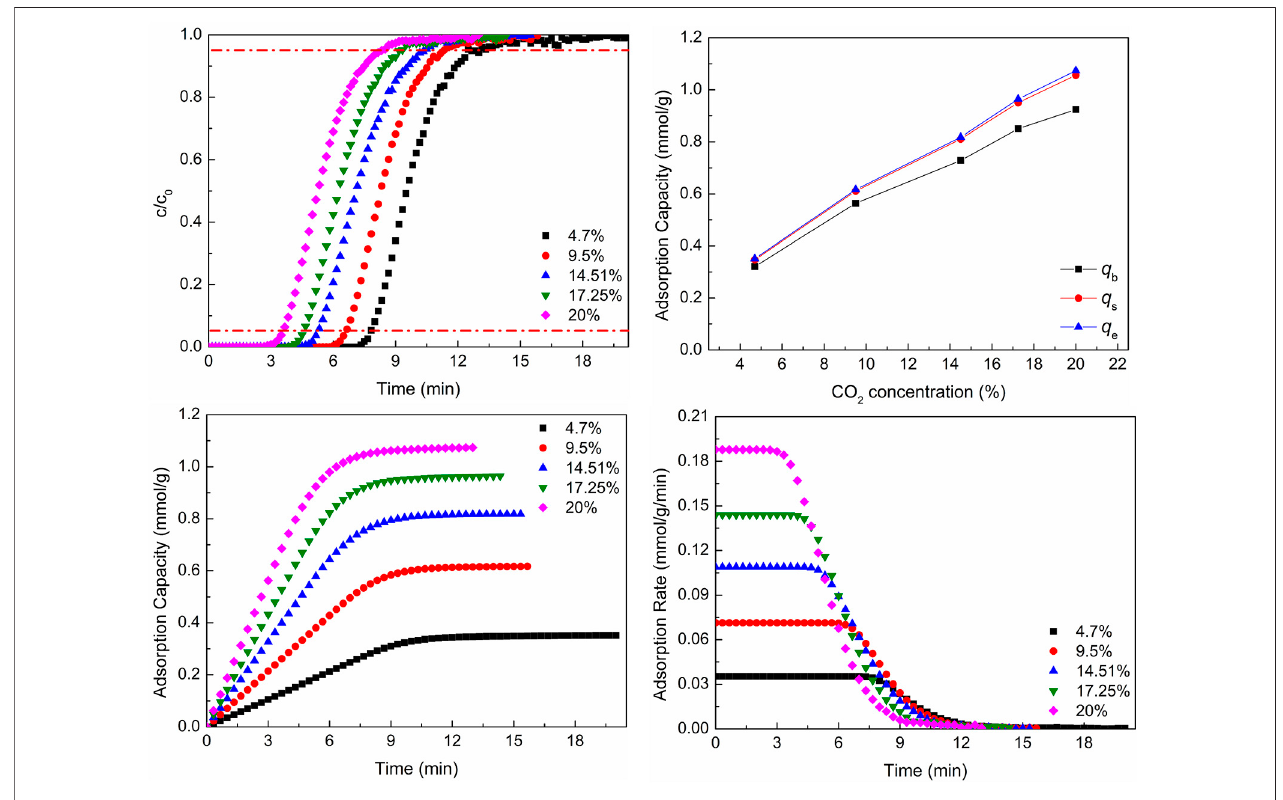
FIGURE 6 | CO 2 adsorption properties at different CO 2 concentrations: (A) breakthrough curves; (B) adsorption capacity; (C) adsorption process; (D) adsorption rate.